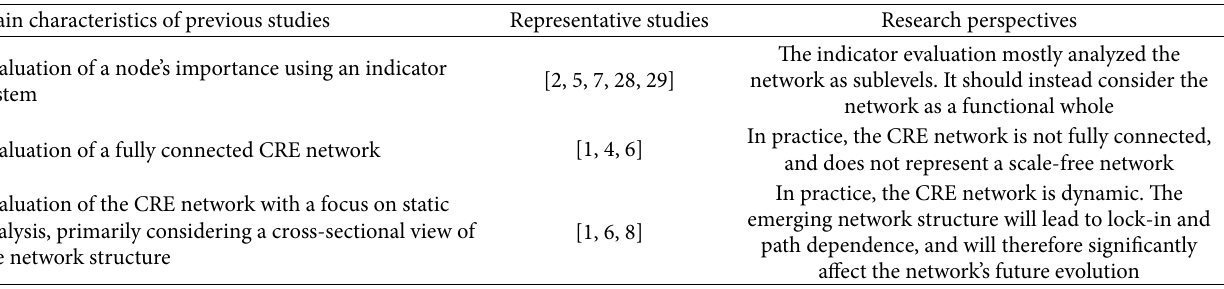
Table 1: Summary and comparison of the research